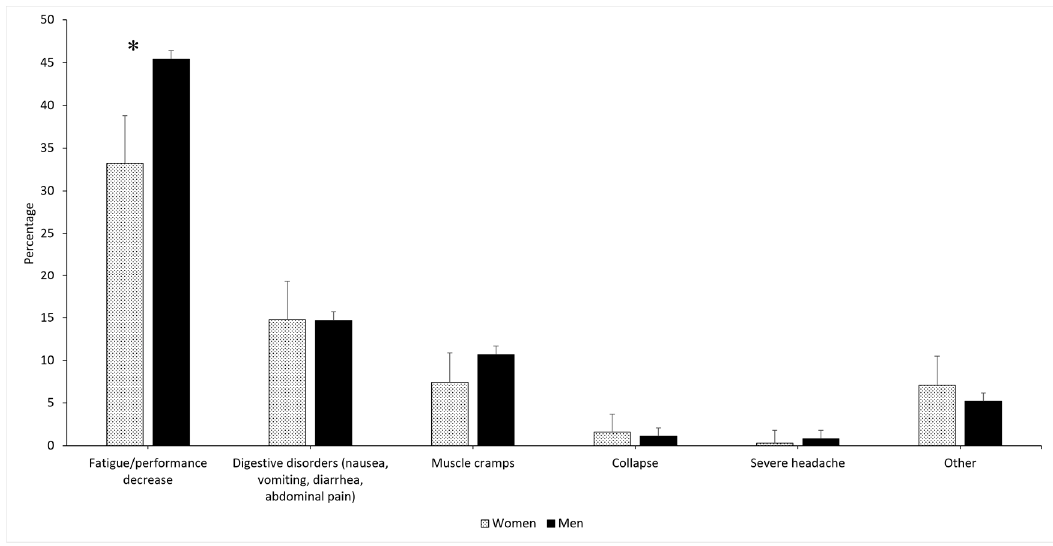
Figure 1. Heat-related symptoms experienced during the race by Grand Raid de la Réunion runners according to sex. * Significant difference between men and women.